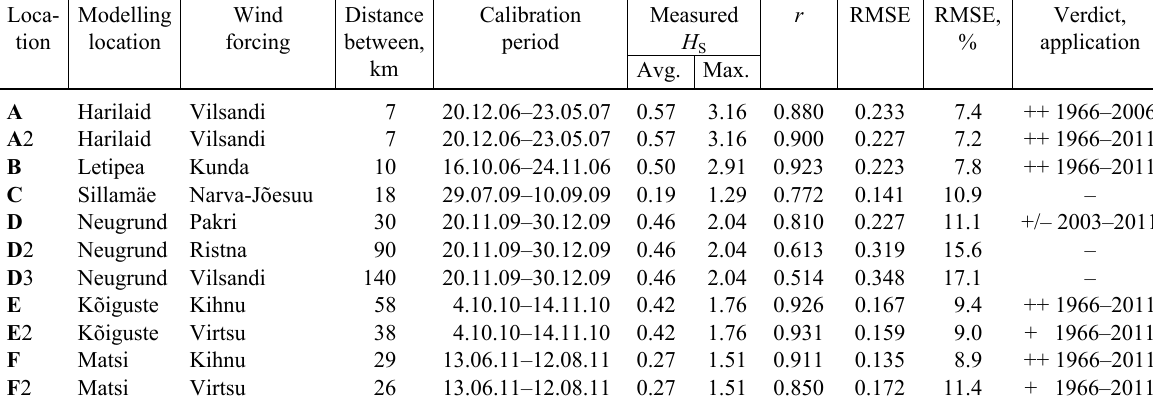
Table 1. Wave model calibration results at different locations (see Fig. 1) of the Estonian coastal sea. The verdict (++ very good, + ok, (cid:150) unusable) is further explained in the